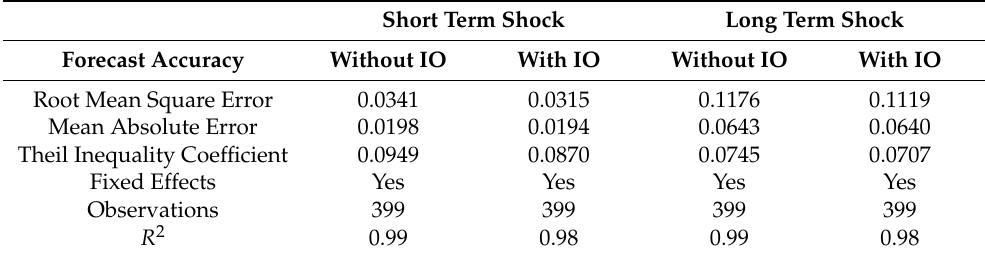
Table 5. Sample 2005–2011—VAR using shadow interest